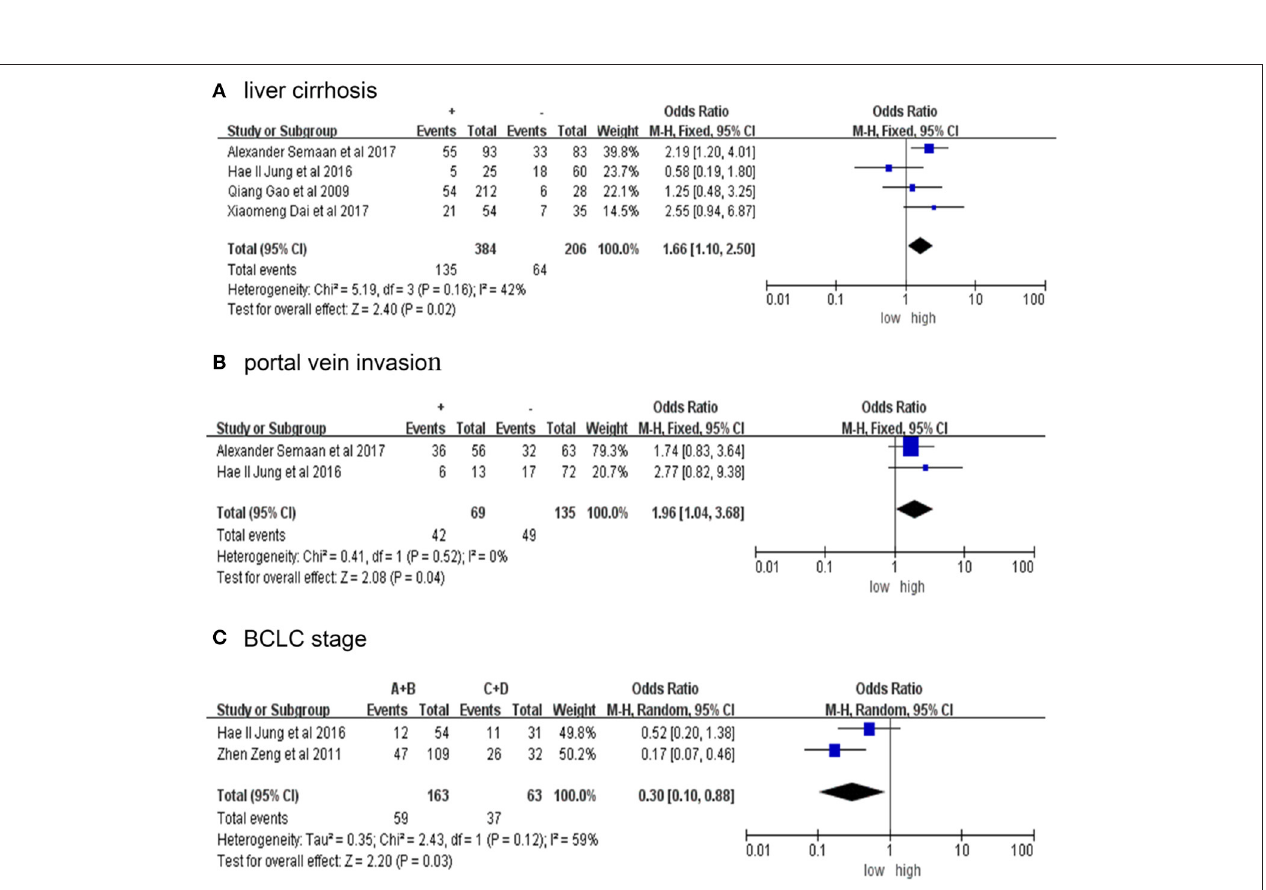
FIGURE 3 | Forrest plot of HR for liver cirrhosis (A) , portal vein invasion (B) , BCLC stage (C) + represent positive, - represent negative. Size of the square indicates the relative contribution of each study. The solid horizontal line represents 95% confidence interval of each study. The diamond indicates pooled studies.